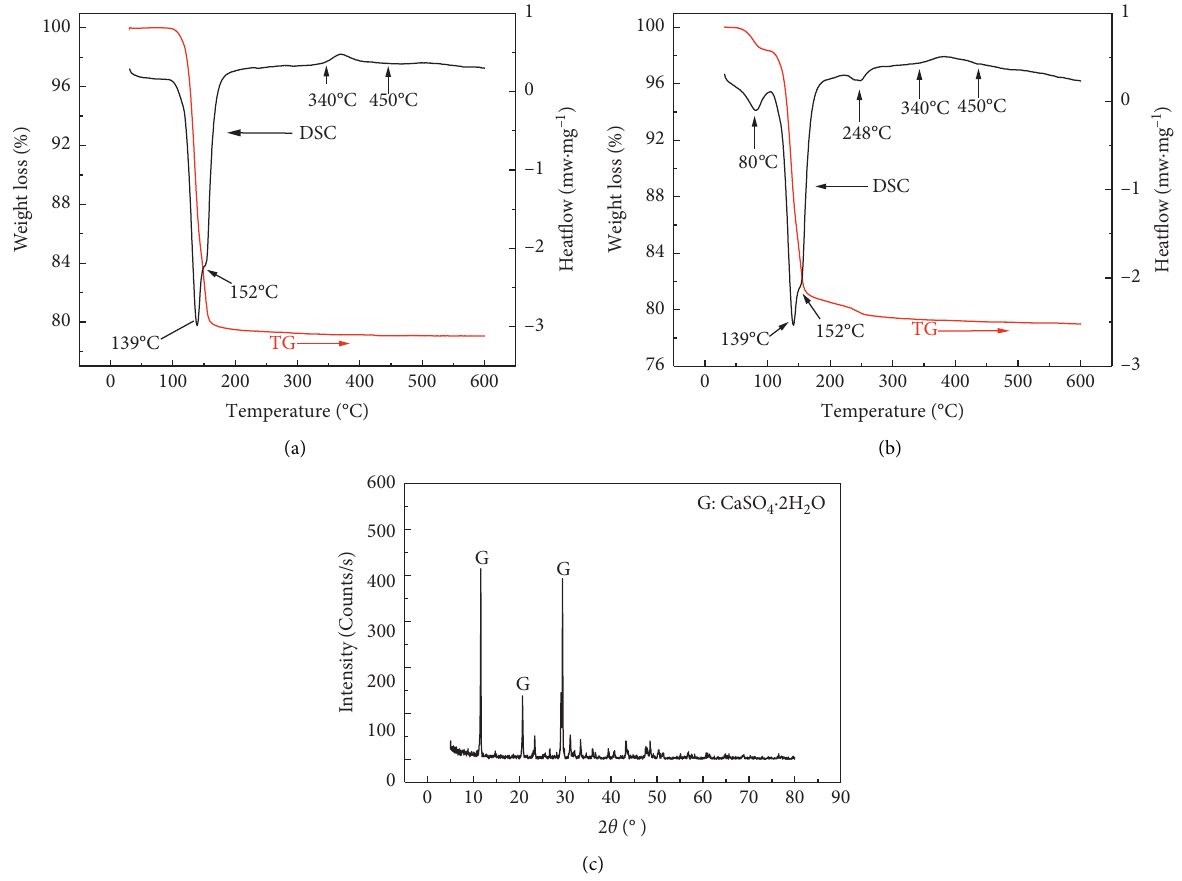
Figure 11: DSC/TG curves of hardened CP (a) and hardened CAP (b) and XRD patterns of hardened CP